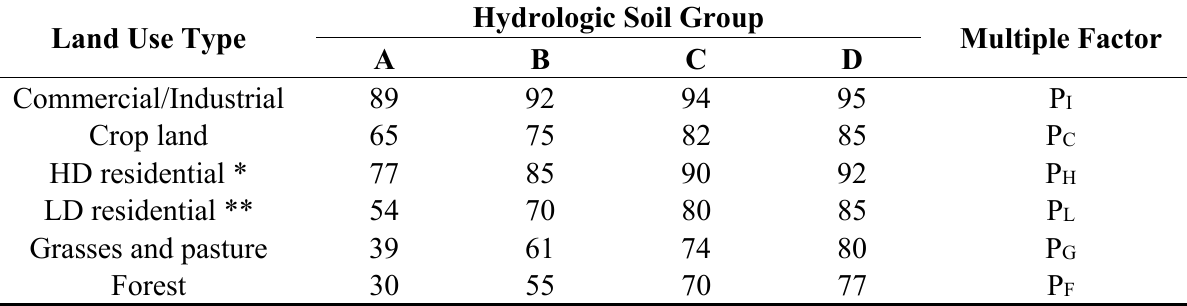
Table 3. Default CN values in this